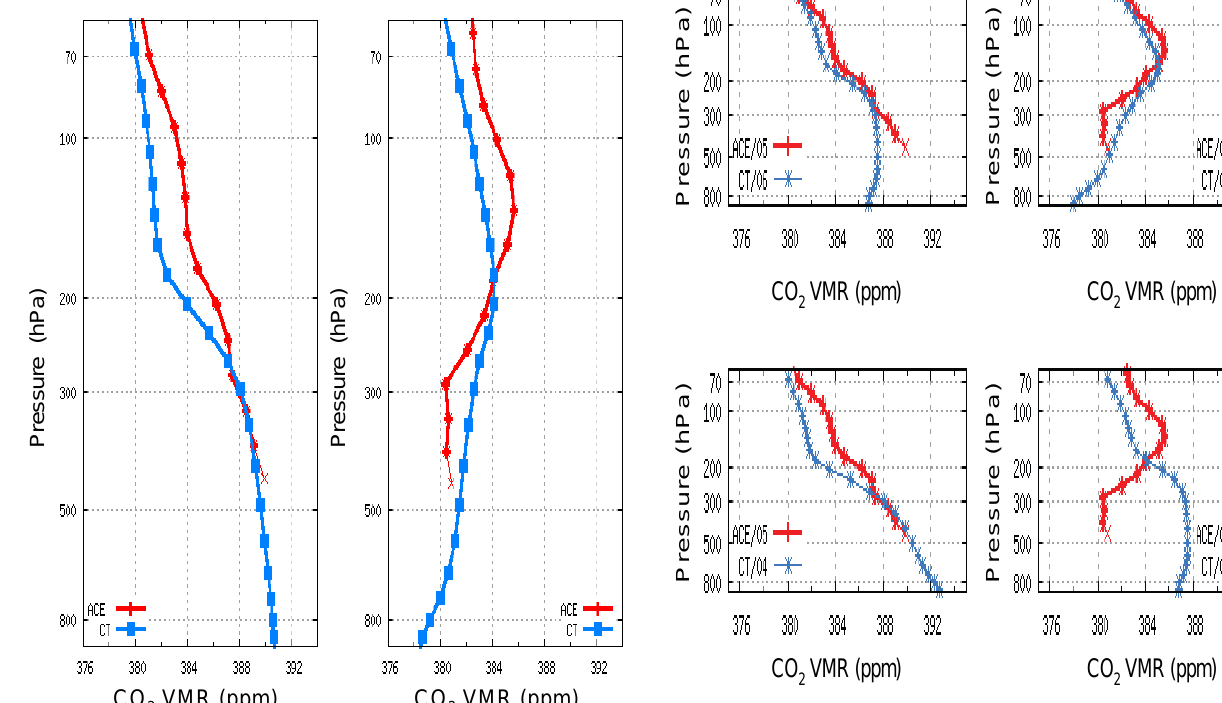
Fig. 10. Same as Fig. 7 for the year 2008.